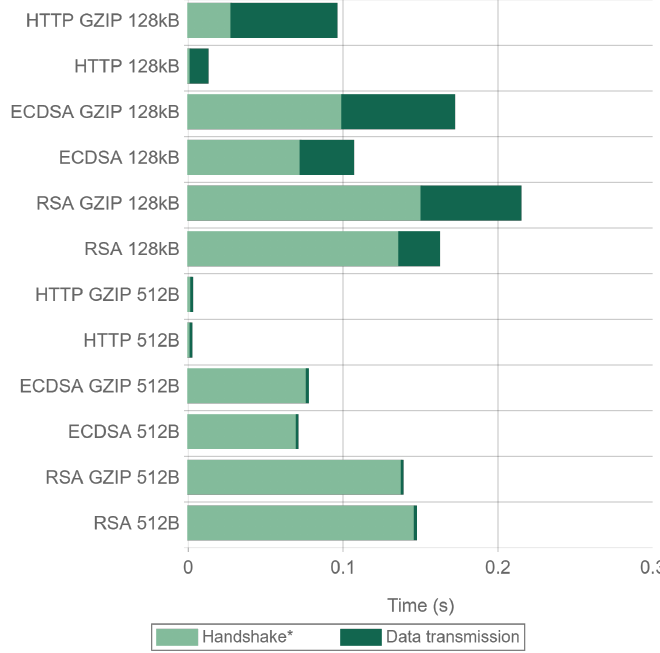
Figure 22. Handshake and payload communication times for 512-byte and a 128-kilobyte payloads using Elliptic Curve Digital Signature Algorithm (ECDSA), Rivest–Shamir–Adleman (RSA), and HTTP, with and without GNU ZIP (GZIP) compression using Nginx. * HTTP handshake for HTTP, Transport Layer Security (TLS) and HTTP handshakes for ECDSA and